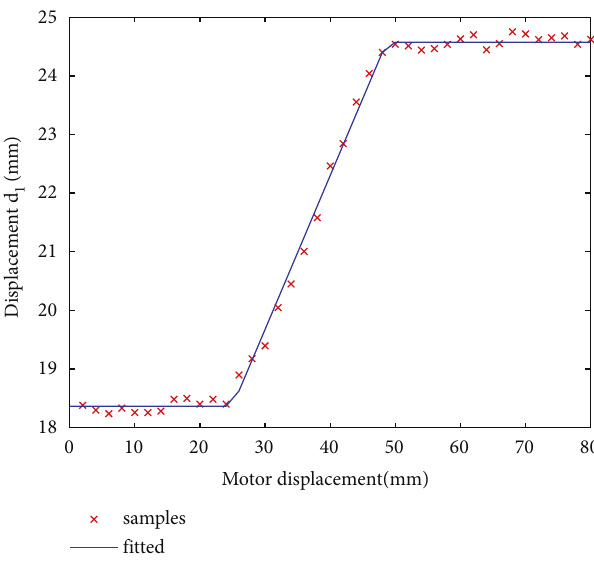
Figure 8: Samples and the fi tted curve of displacement d volunteer